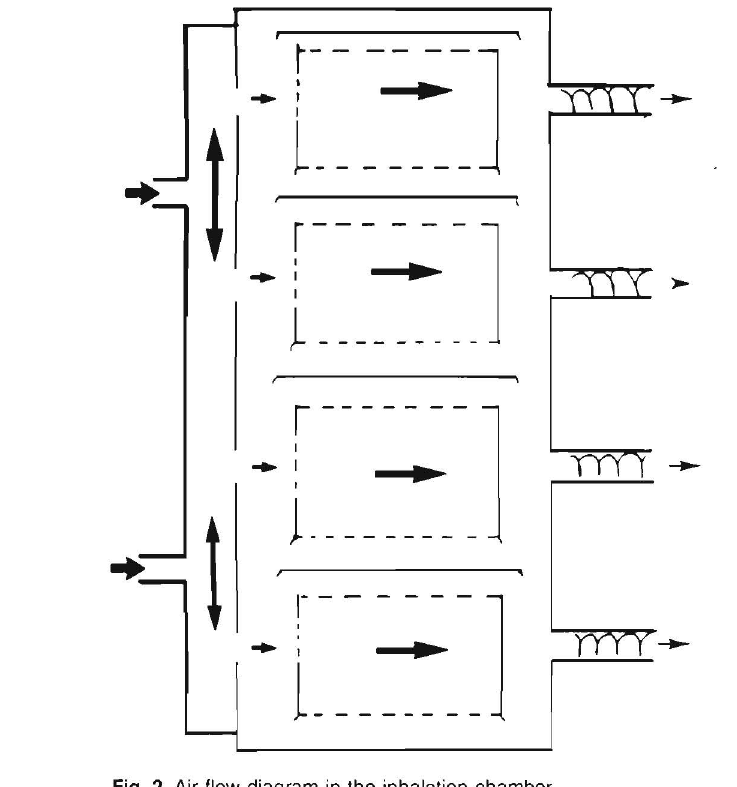
Fig. 2 Air flo'(\' diagram in the inhalation chamber.